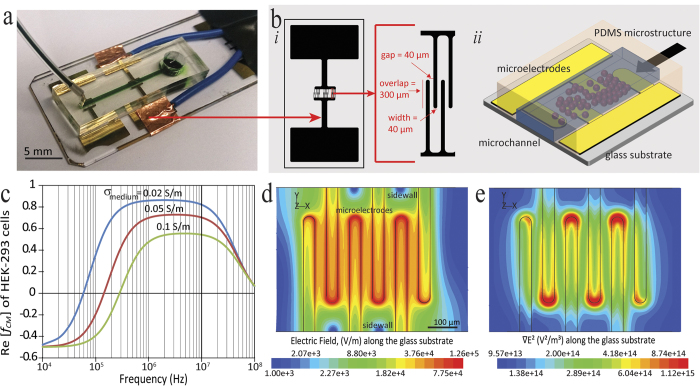
Microfluidic platform used for studying robust immobilisation of cells.(a) The actual microfluidic platform. (b) Plan view of inter-digital microelectrode design with dimensions of microelectrodes. (c) Frequency variation of the real part of the Clausius-Mossotti factor, indicating the DEP response of HEK-293 cells at different frequencies. (d) Contours of electric field at the surface of glass substrate, obtained by numerical simulations at an operating voltage of 5 Vpk-pk. (e) Contours of the gradient of electric field square at the surface of glass substrate, obtained by numerical simulations at an operating voltage of 5 Vpk-pk.